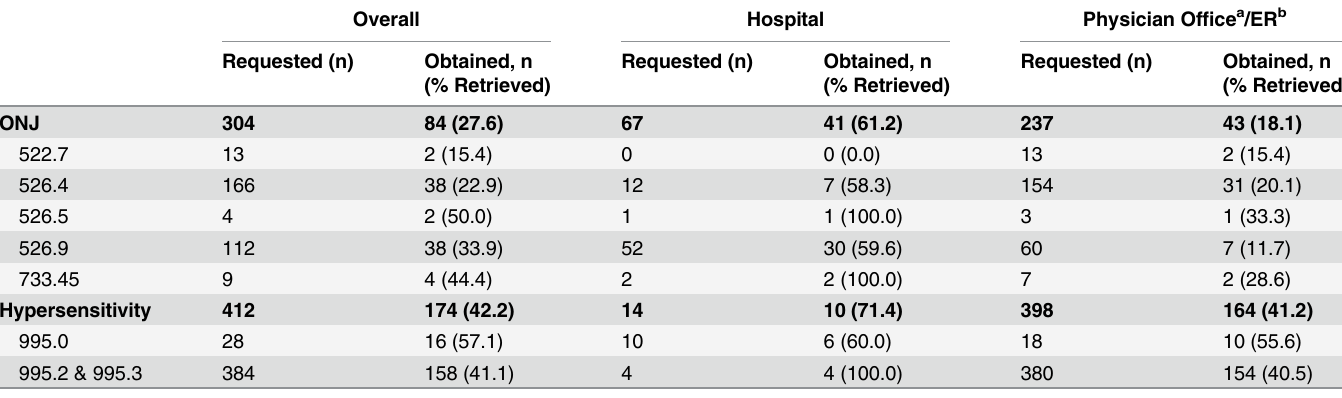
Table 2. Proportion of Successfully Retrieved Medical Records by Facility Type.